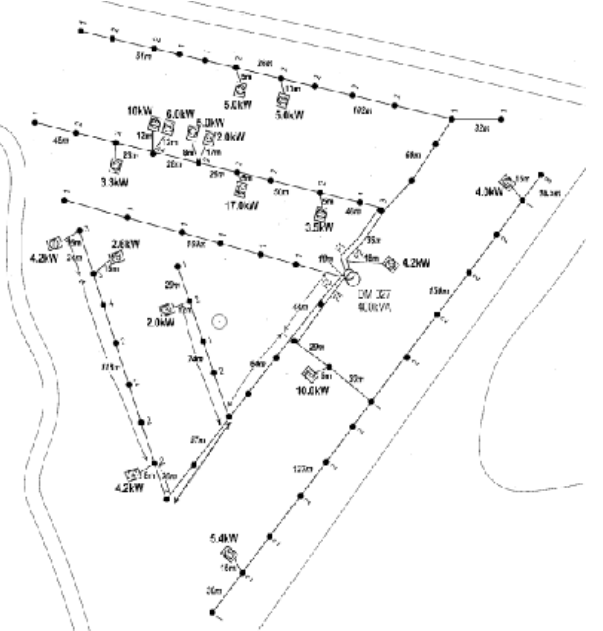
Figure 4: Single line diagram of Lotus Grove Housing